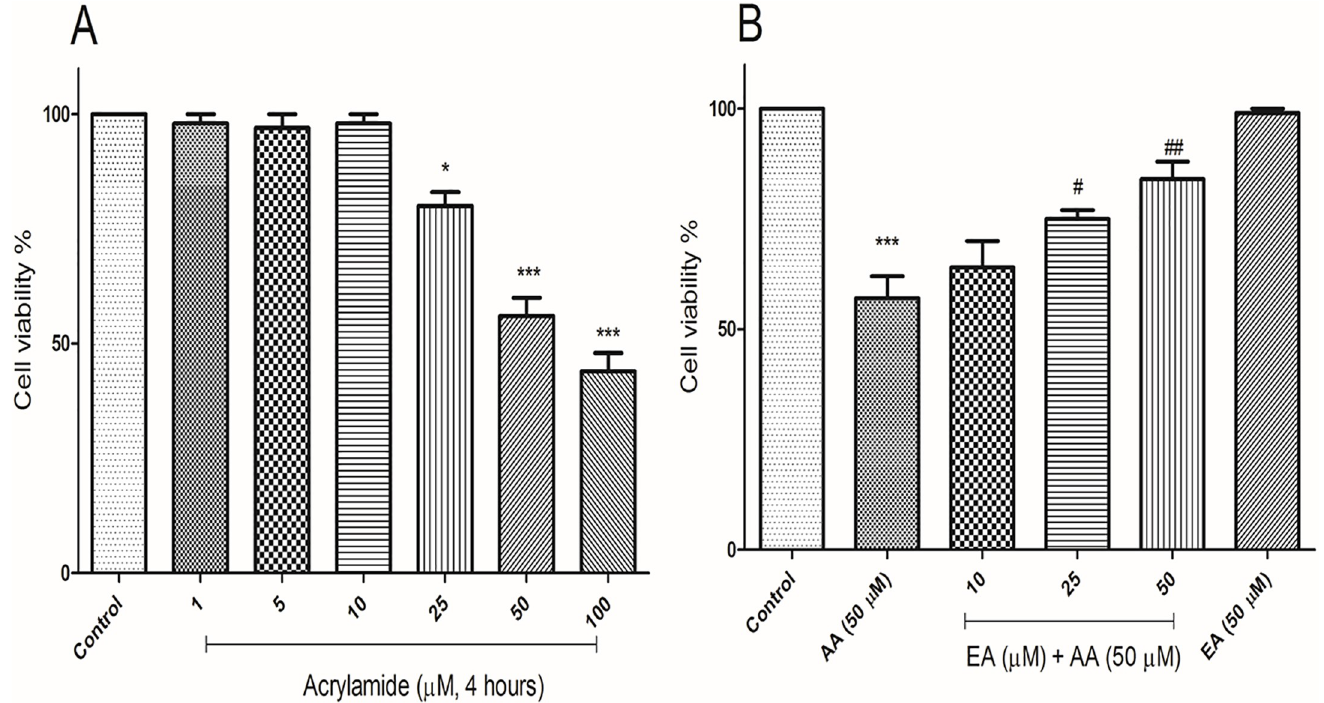
Fig 1. Ellagic acid reduces cytotoxicity effects of AA in human lymphocytes. (A) Representative MTT assay of human lymphocytes treated with AA in a range of 1 μ M to 100 μ M (10,000 cells per well, n = 3 technical replicates; independent experiments repeated at least 3 times) at 4 hours. (B) Representative MTT assay of human lymphocytes treated with AA (50 μ M) and EA in a range of 10 μ M to 50 μ M (10,000 cells per well, n = 3 technical replicates; independent experiments repeated at least 3 times) at 4 hours. Data are presented as mean ± SD, n = 3, ��� p < 0.001: Control versus AA; #p < 0.05, ##p < 0.01: AA + EA versus AA-treated human lymphocytes ANOVA, Tukey’s